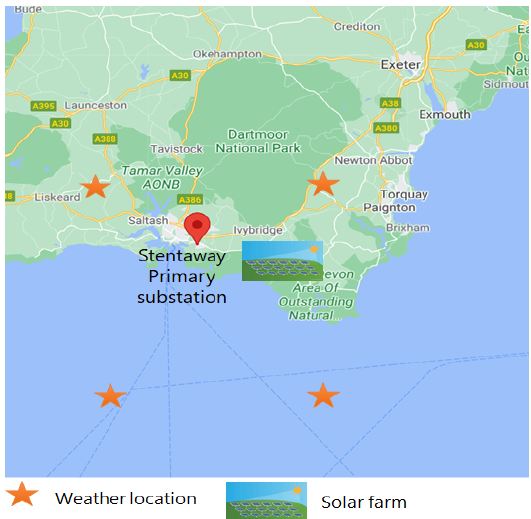
Figure 2. Overview of the area considered for the study: the location of the substation, PV farms and four surrounding weather stations are shown. Map data c (cid:13) 2021